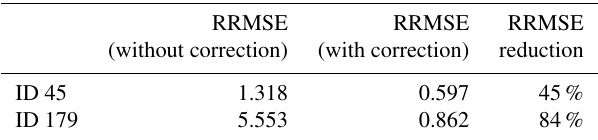
Table 3. RRMSE values for two selected water provinces without and with correction for snow cover when evaluating simulated TWS